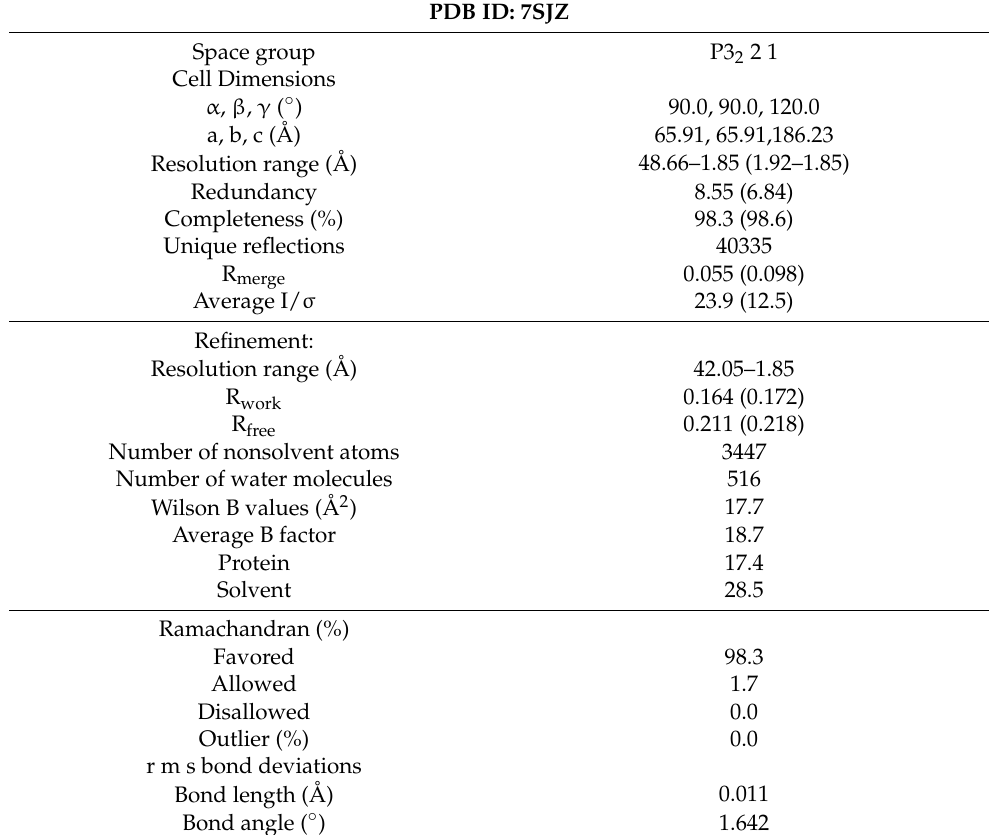
Table 2. Data collection and refinement statistics for the α Ser A Pt NHase mutant enzyme